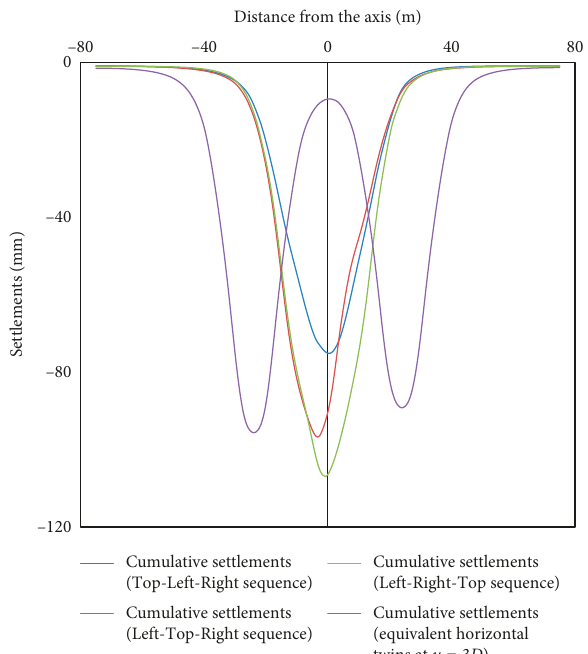
Figure 12: Settlement comparison of equivalent horizontal twin tunnels and the triplet